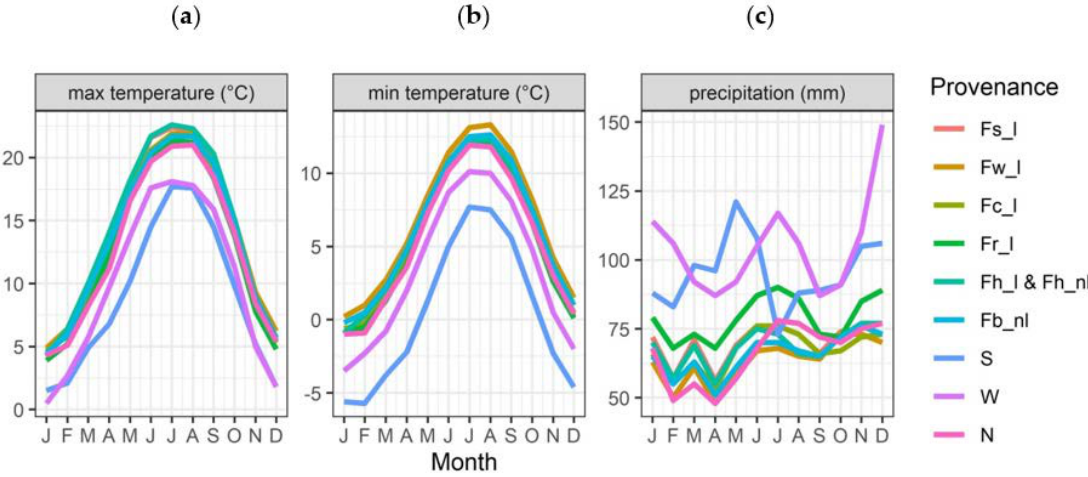
Figure 2. Climate at the growth sites of the provenances of F. sylvatica L.(data from WorldClim). ( a ) Mean monthly maximum temperature; ( b ) mean monthly minimum temperature; ( c ) mean monthly precipitation. Abbreviations of provenances in Table 1.